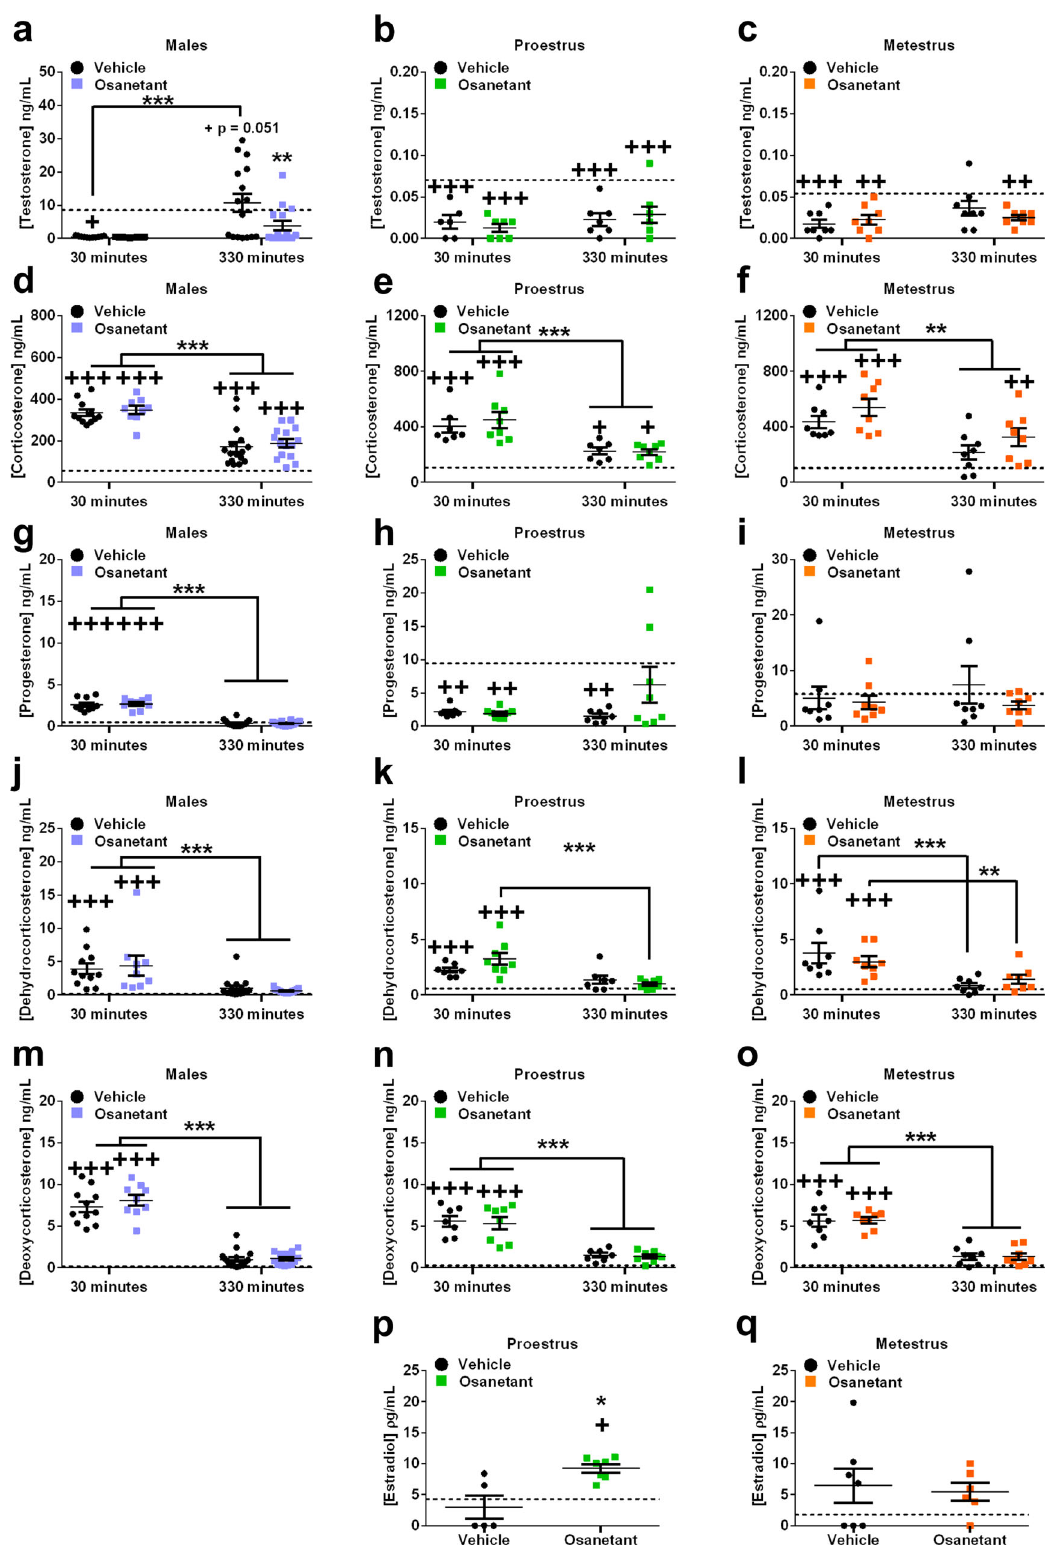
a similar direction than the behavioral effects on memory consolidation. Nk3R expression is similar in males and proestrous and metestrous females, with increased colocalization of Nk3R